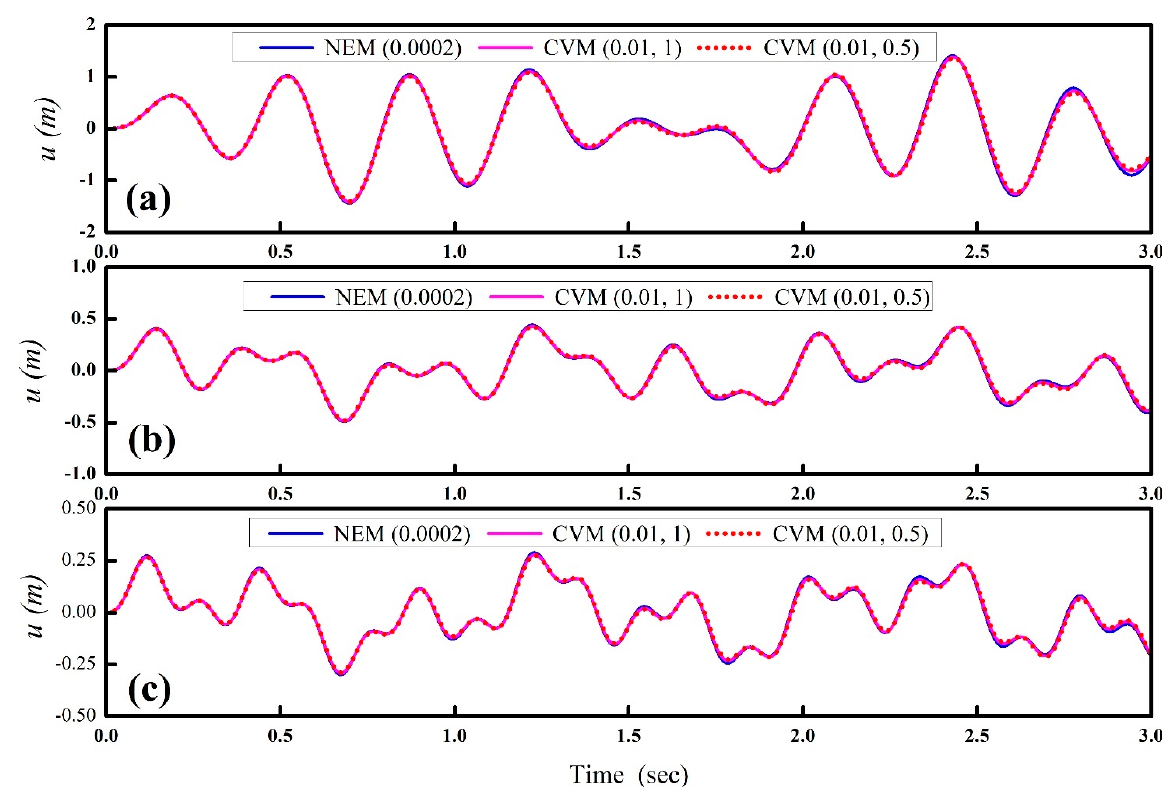
Figure 15. Eight-storey shear beam building with external force.